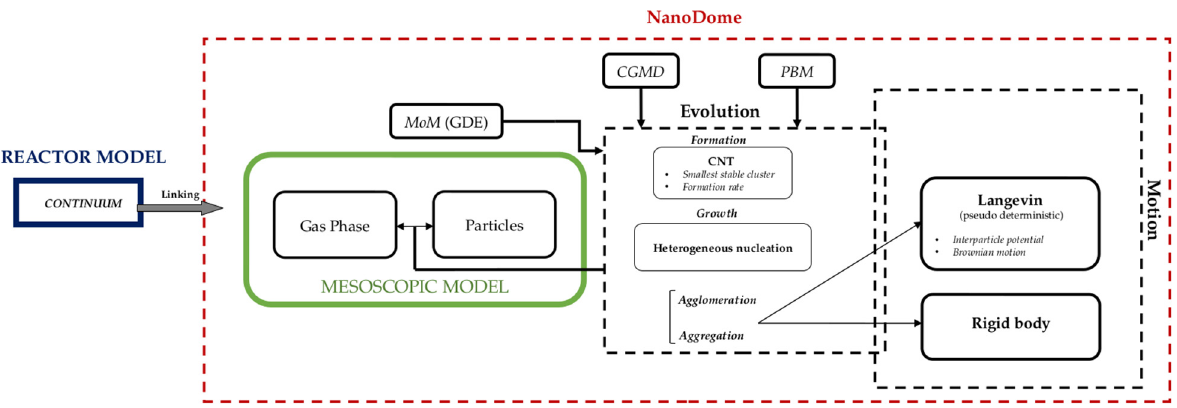
Figure 1. Conceptual workflow diagram of the linking and mesoscopic system modelling adopted in this work.